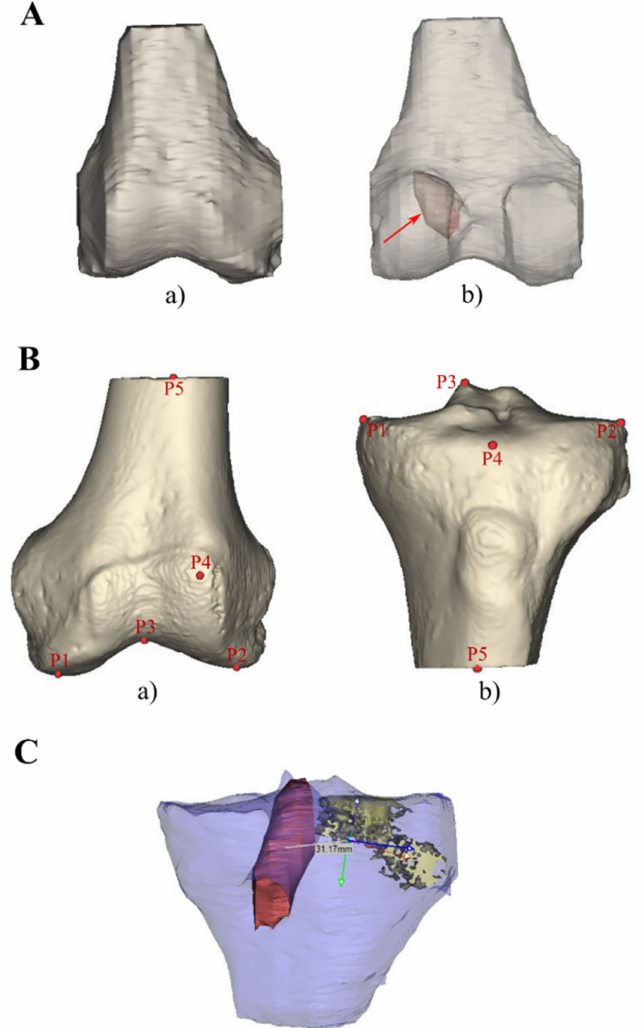
Figure 4. ( A ) 3D surface model of the distal femur: ( a ) opaque model, ( b ) transparent 3D model with the indicated bone tunnel (red arrow). ( B ) Location of the landmarks. Femur: P1—the farthest point on the medial condyle, P2—the farthest point on the lateral condyle, P3—intercondylar fossa, P4—lateral peak, P5—the center of the diaphysis. Tibia: P1—medial peak, P2—lateral peak, P3— medial intercondylar tubercle, P4—frontal peak, P5—center of the diaphysis; ( C ) Measurements of the distance between the center of mass of the bone tunnel and bone